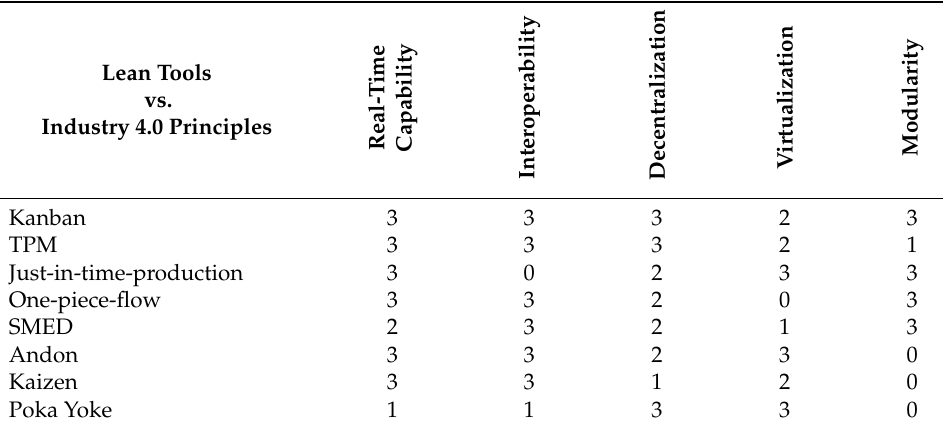
Table 8. Analysis of the article “Compatibility, opportunities and challenges in the combination of Industry 4.0 and Lean Production”